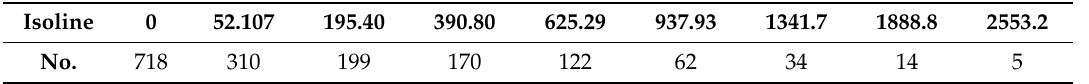
Table 4. Isoline set of the kernel density surface of the commercial POIs.